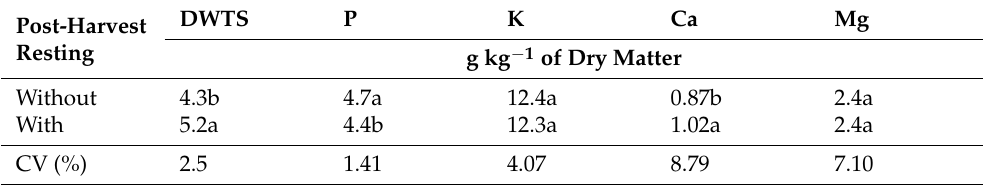
Table 1. Dry weight of one thousand seeds (DWTS), phosphorus (P), potassium (K), calcium (Ca) and magnesium (Mg) content in sweet pepper seeds as a function of post-harvest resting of fruits.